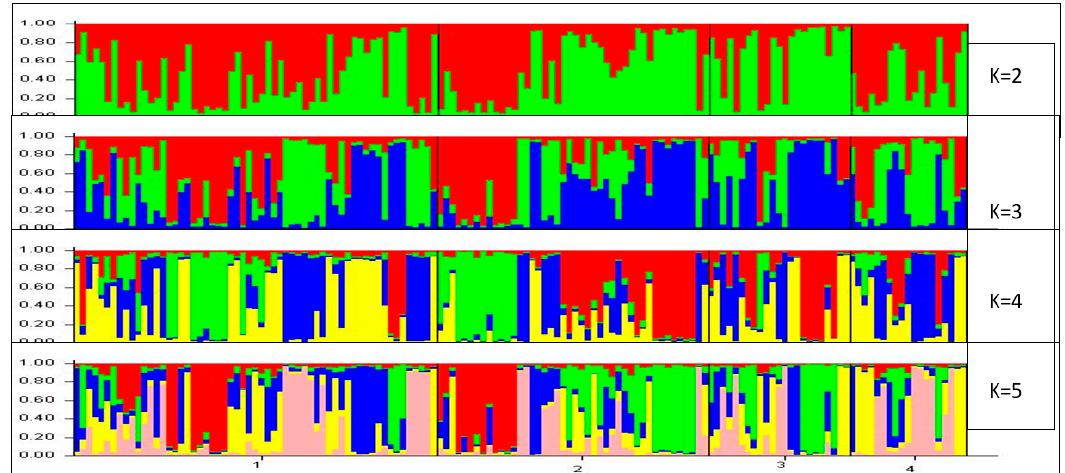
Figure 2. Genetic structure of the Chusca Lojana. Cluster diagram of the population for K ranging from 2 to 5.